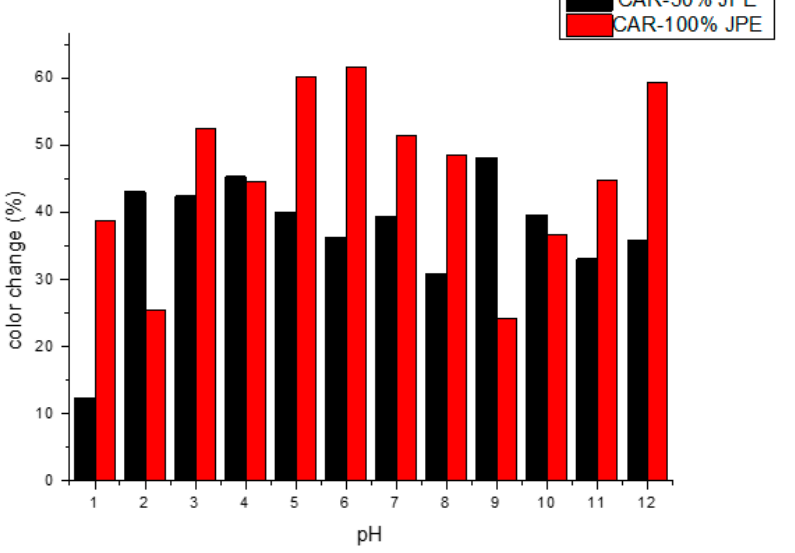
Figure 2. Colorimetric results measured after the sample contact with different buffer solutions and their respective pH value.